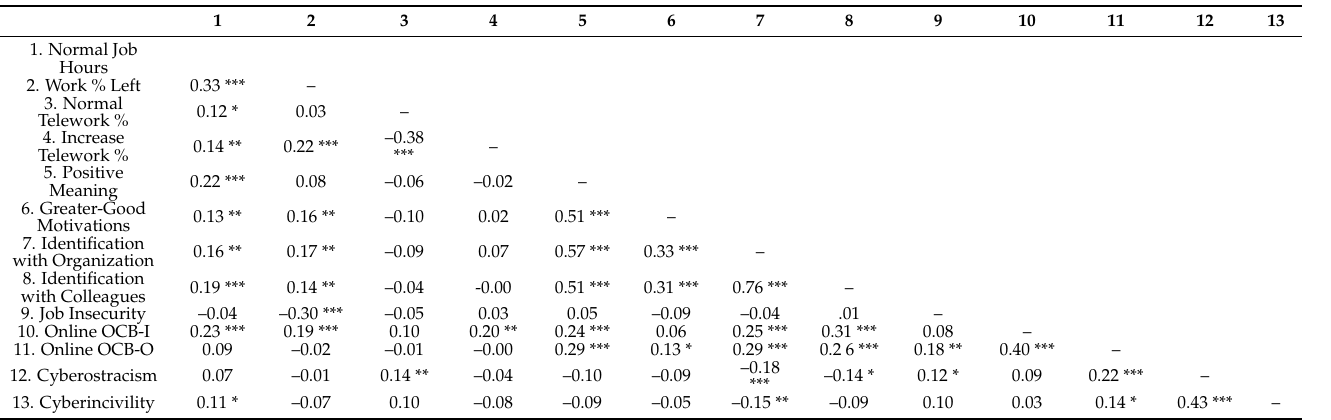
Table 3. Correlations between variables.